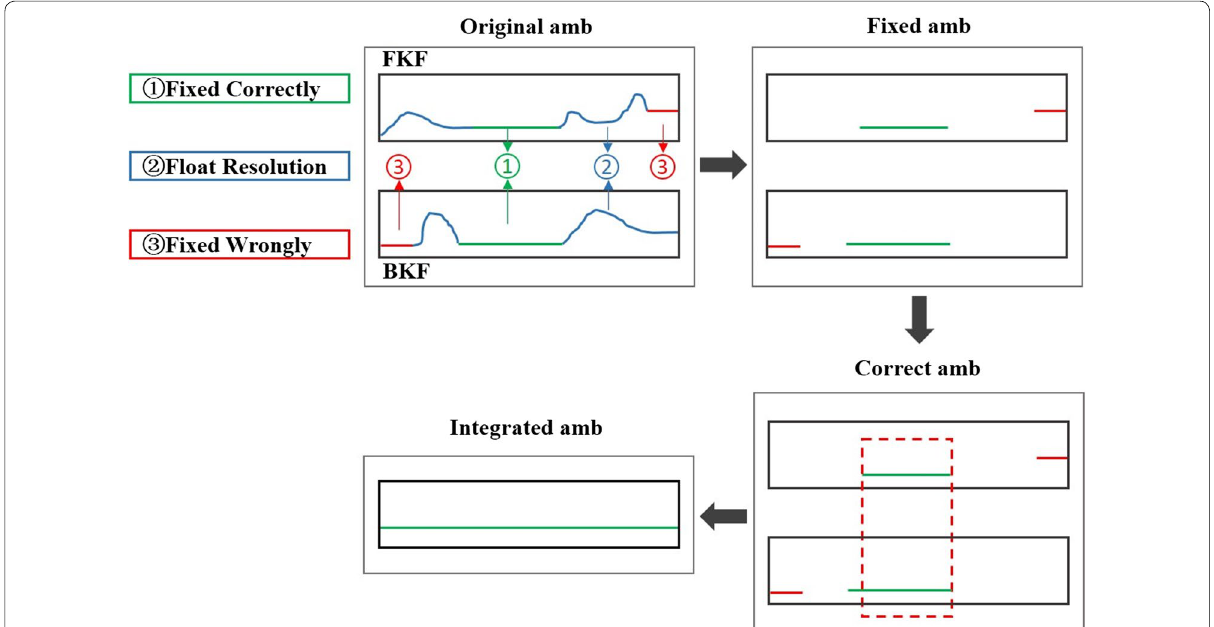
Fig. 2 Schematic diagram of the ADBI method. The curves in the black frame denote the status of ambiguities for one satellite in forward KF (top) and backward KF (bottom) during the same period of time. Each gray frame denotes the status of ambiguity after each step of ADBI. In this figure, “amb” means